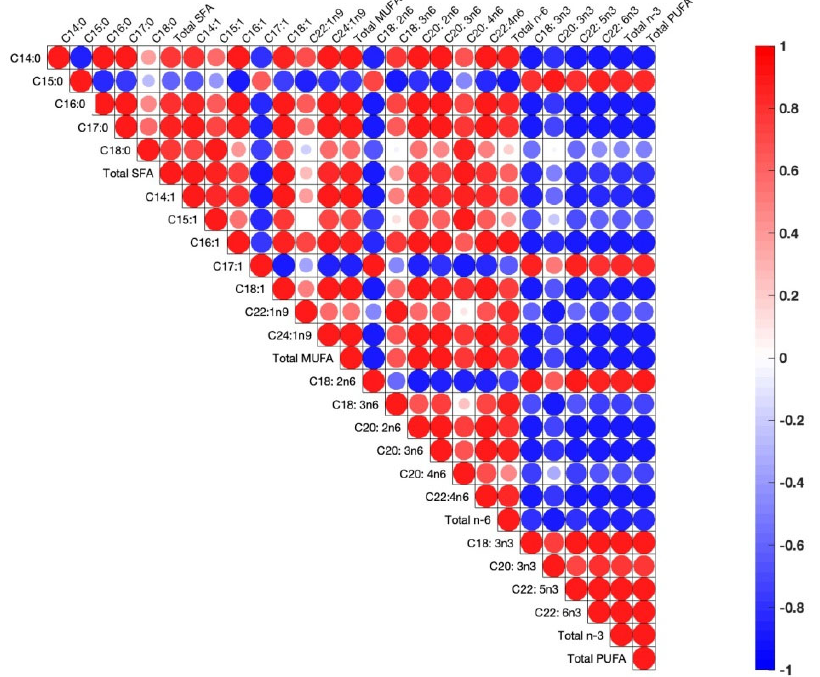
Figure 2. Pearson correlations among egg yolk fatty acids. The correlations are expressed by circles. Blue and red circles indicate positive and negative correlations in each pair, respectively ( p < 0.05). Shapes of circles are dependent on weak to strong correlations from big to small circles.